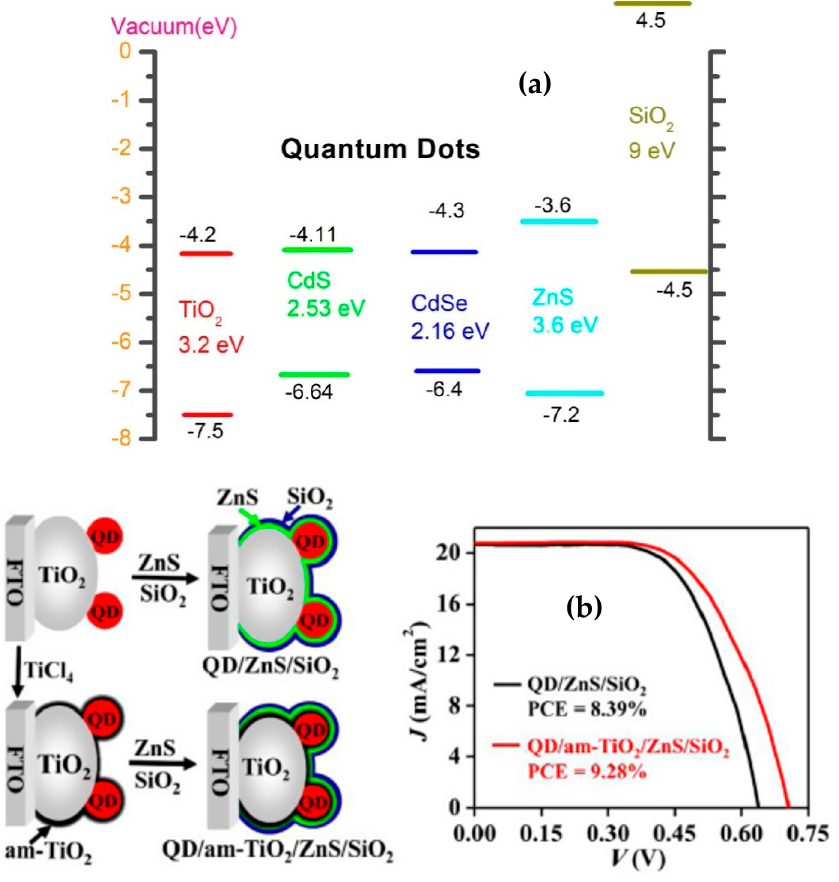
Figure 5. ( a ) Schematic diagram of the energy level of an QDSSC’s photoanode [101] and ( b ) the enhancement in QDSSCs performance by using a passive surfactant from Ren and co-work, 2015 [105].